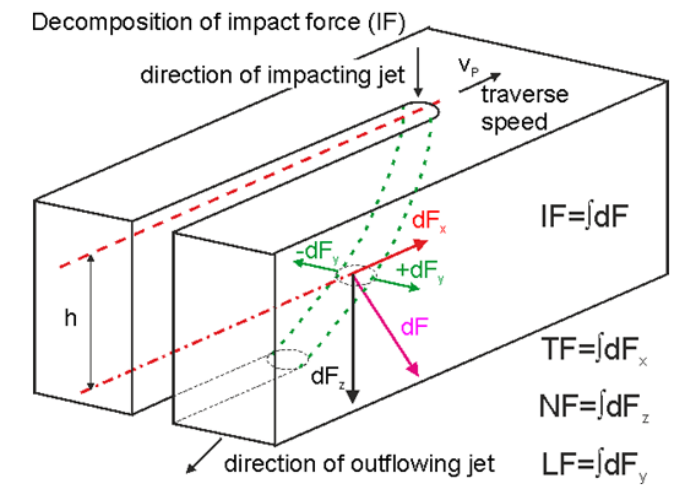
Figure 1. Decomposition of the total impact force acting on the kerf head into the cutting (TF), deformation (NF) and transverse (LF) forces; the forces elements are distinguished by subscripts corresponding with force sensor axes directions, measured values are integral values in the selected direction at a given moment.